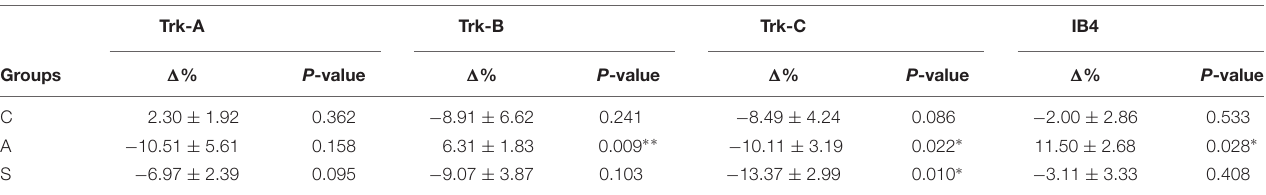
FIGURE 5 | (A) Microphotographs of Trk- ad IB4- positive neurons from left ganglia of an axotomized animal. Scale bar = 20 µ m. (B) Representative mechano-proprioceptors (TrkB, TrkC) and thermo-nociceptors (TrkA, IB4)-reacted slices showing positive neurons in the left ganglion of Control (C), Amputated (A), and Stimulated (S) animals. Scale bar = 50 µ m for all the images. (C) Graphic representation of mean percentage changes in the number of Trk- and IB4-positive neurons between left and right TG indicated as L/R (%). Intra-group comparisons for mechano/proprioceptors show a significant increase in the number of TrkB-positive neurons and a decrease in the number of TrkC-positive ones after axotomization. Electrical stimulation of the transected nerve prevents such effect in the case of TrkB neurons while it potentiates the decrease of TrkC-positive cells. A similar effect is observed in the case of thermo-nociceptors: the number of IB4-positive increases while the number of TrkA-positive neurons diminishes, although TrkA decrease does not reach significant levels. Electrical stimulation of the amputated nerve reverses axotomy effects or prevents changes for both markers. Inter-group comparisons show significant differences between A and C-S groups in both TrkB- and IB4-positive neurons. Intragroup significant differences are indicated by asterisks (paired t -test, ∗ P < 0.05; ∗∗ P < 0.01). Intergroup significant differences are indicated by hashtags (one-way ANOVA followed by post hoc LSD test, # P < 0.05; ## P < 0.01). TABLE 5 | Whole trigeminal